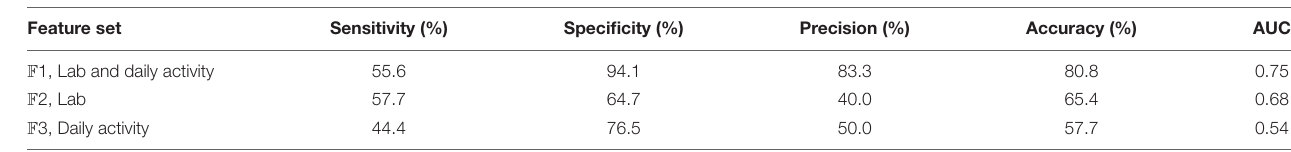
F 1: Selected 19 features marked with crosses in Figure 1 . F 2: 7 lab features from F 1. F 3: 12 daily activity features from F 1.